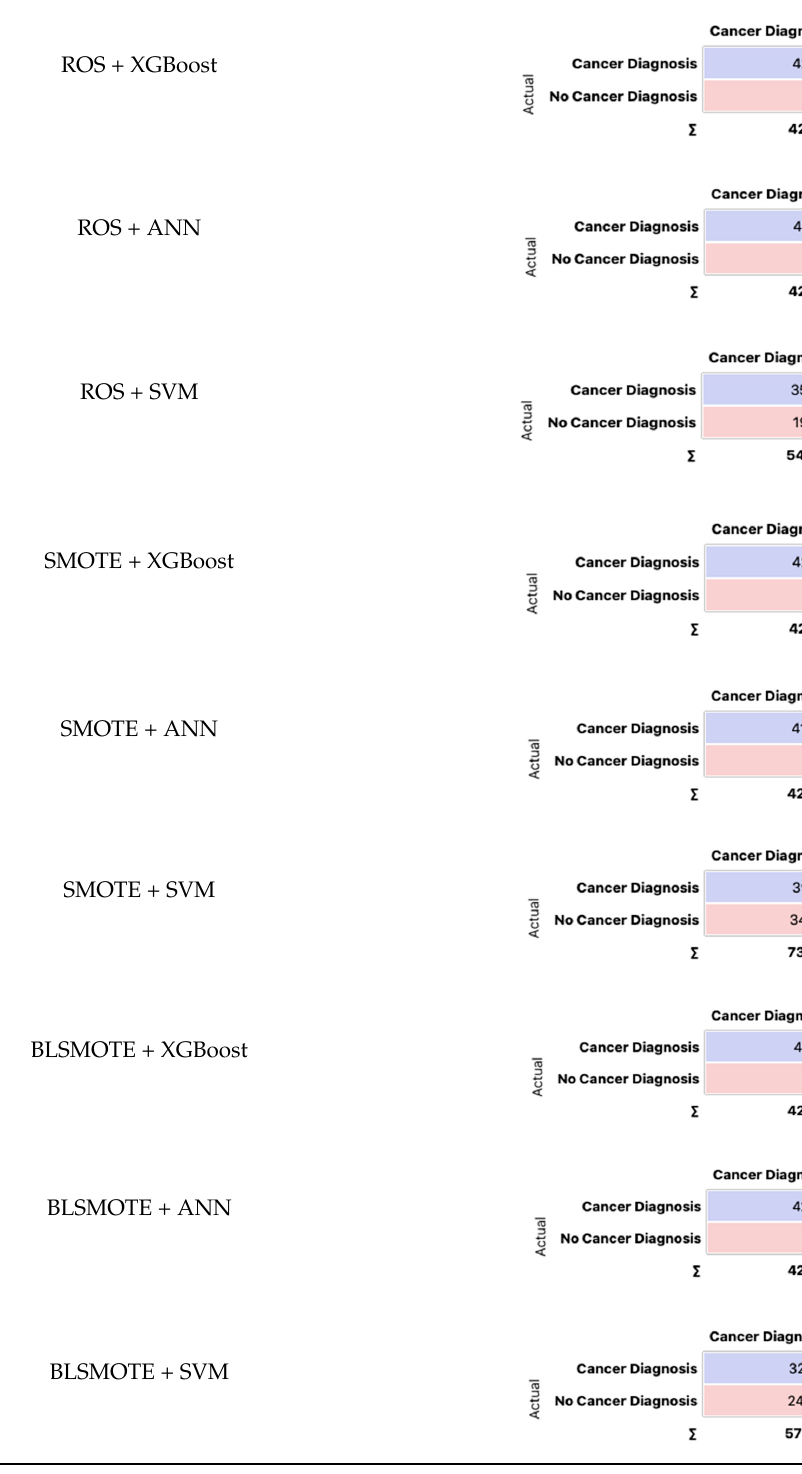
Table 10. Confusion matrix of the fusion model for datasets balanced using undersampling tech-